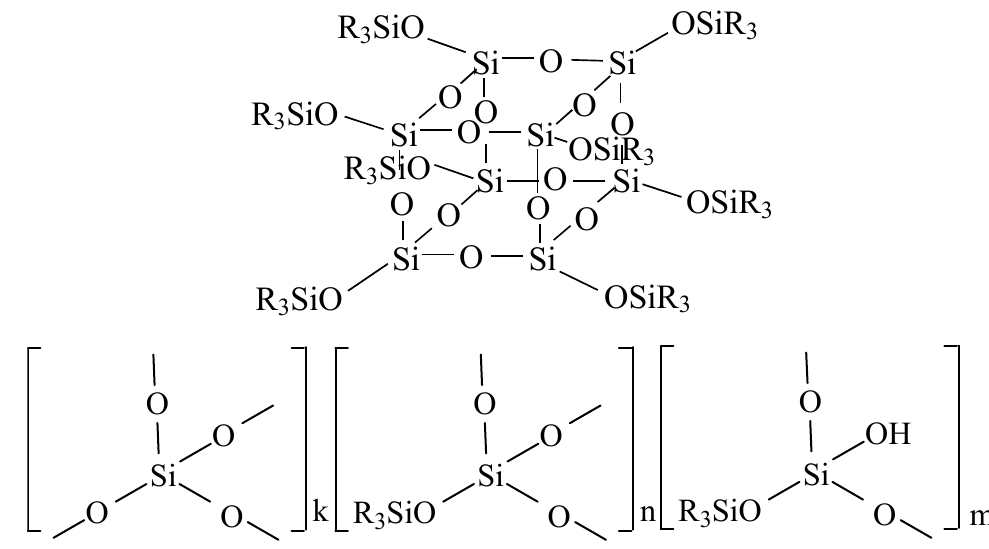
Figure 1. An ideal structure of a cubane M 8 Q 8 and a real structure of MQ-copolymer.